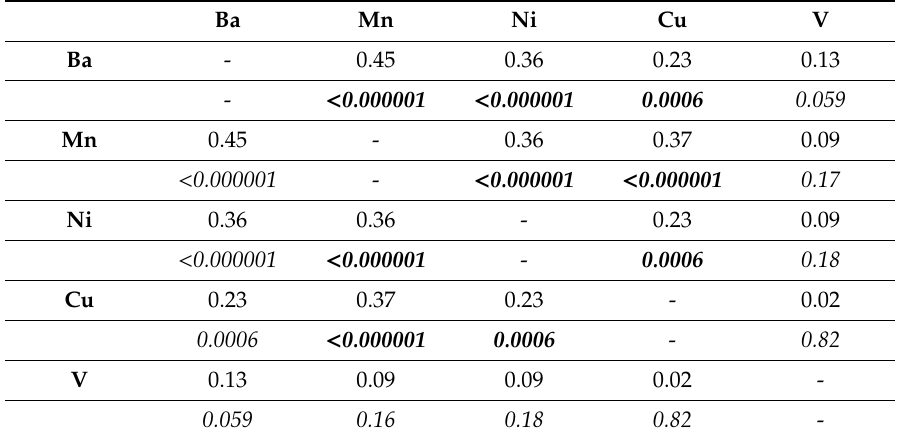
Table 3. Spearman’s correlation matrix considering the toenail concentrations of Ba, Mn, Ni, Cu, and V in the whole group of enrolled children (n =